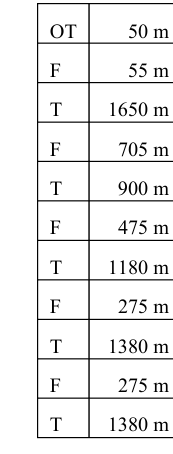
Figure 7. Induced current magnitudes in the three screens for case #1. Figures 8–10 give the subdivision into elementary cells performed for cases #2–#4. Figure 8. Subdivision of case #2 in elementary cells, minor and major sections. OT—open trefoil with spacing = 0.225 m; F—flat laying with spacing = 0.35 m; T—close trefoil. Minor section=490 m Major section=490 m × 3=1470 m Multiconductor cell length =10 m Major section=1470 m